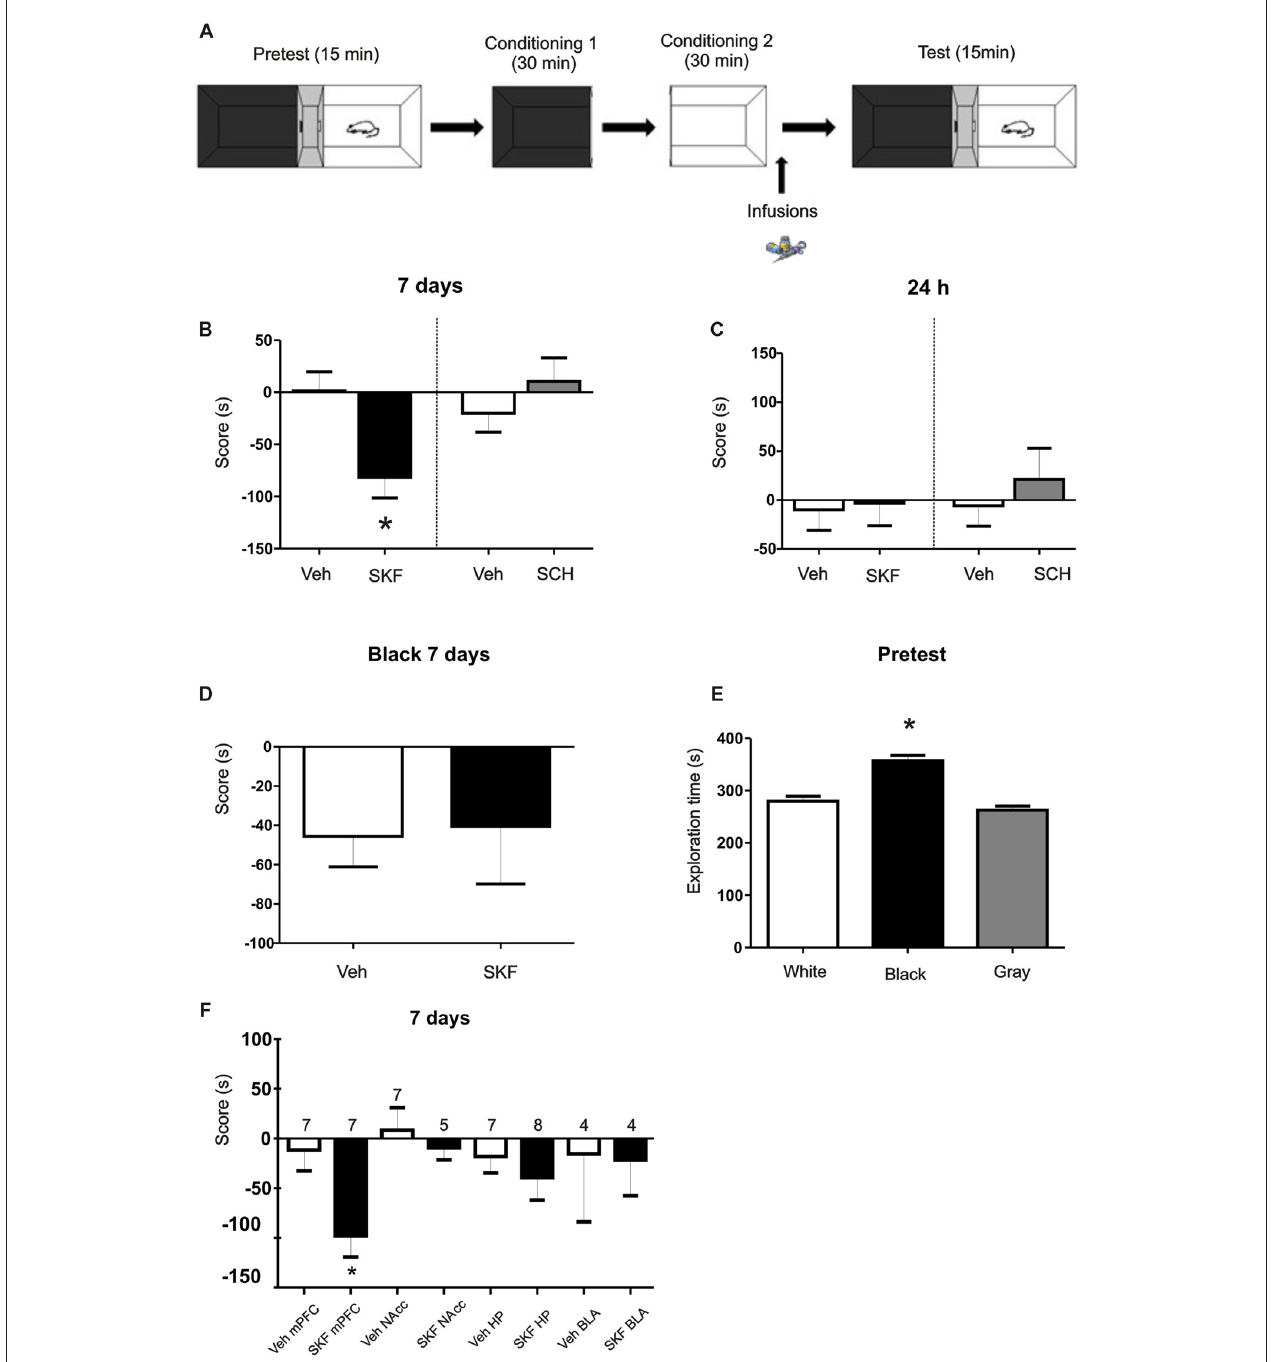
FIGURE 1 | Infusion of D1/5R agonist SKF 38393 in medial prefrontal cortex (mPFC) produces an aversive behavior. (A) Schema of the protocol used. (B) Animals were infused with the D1/5R antagonist SCH 23390, with the D1/5R agonist SKF 38393 or their respective vehicles in the mPFC region immediately after the exposure of the white compartment. When animals were tested 7 days later, animals infused with SKF 38393 show an aversive behavior regarding the white compartment (Veh vs. SKF p = 0.0074, n = 9). (C) No effect of any of the drugs was observed when animals were tested at 24 h ( p > 0.05, n = 6). (D) Infusions of SKF 38393 immediately after the black compartment exposure. Test was performed 7 days later. No aversive effect was found ( p > 0.05, n = 12). (E) Scores for the pre-test phase of the protocol. Animals show a natural preference for the black compartment ( p < 0.001, black vs. white; black vs. gray, n = 39). (F) Animals were infused with the D1/5R agonist SKF 38393 or vehicle in the hippocampus (Hp), nucleus accumbens (NAcc) or basolateral amygdala (BLA) region immediately after exposure to the white compartment of the apparatus. There is no effect of the D1/5R activation in either structure when test was performed 7 days later ( p > 0.05, n is indicated on each column). ∗ p <